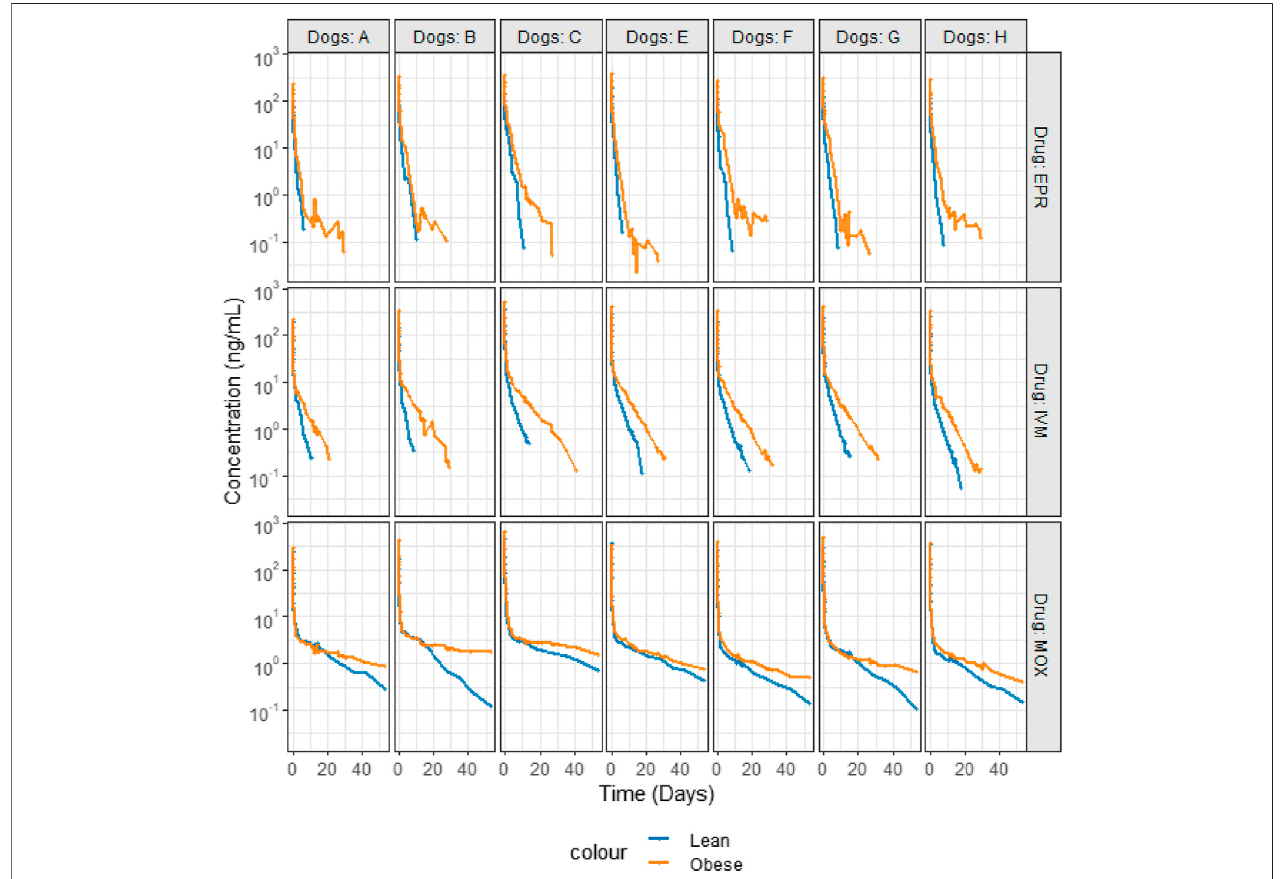
FIGURE 3 | Semi-logarithmic plots of the disposition curves of IVM, MOX, and EPR after a single administration of each drug as a cocktail at the dose rate of 66 μ g/kg by IV injection in seven dogs in control (blue curves) and obesity (orange curves) conditions.